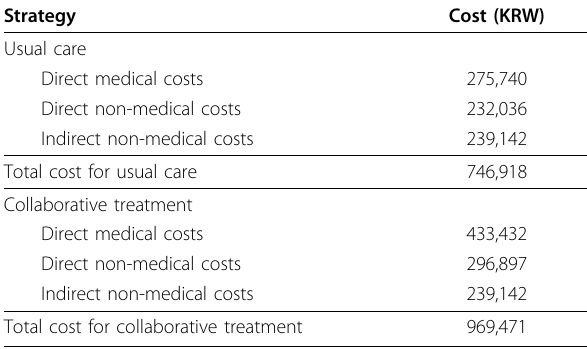
Table 5 Costs of 3 months in the chronic low back